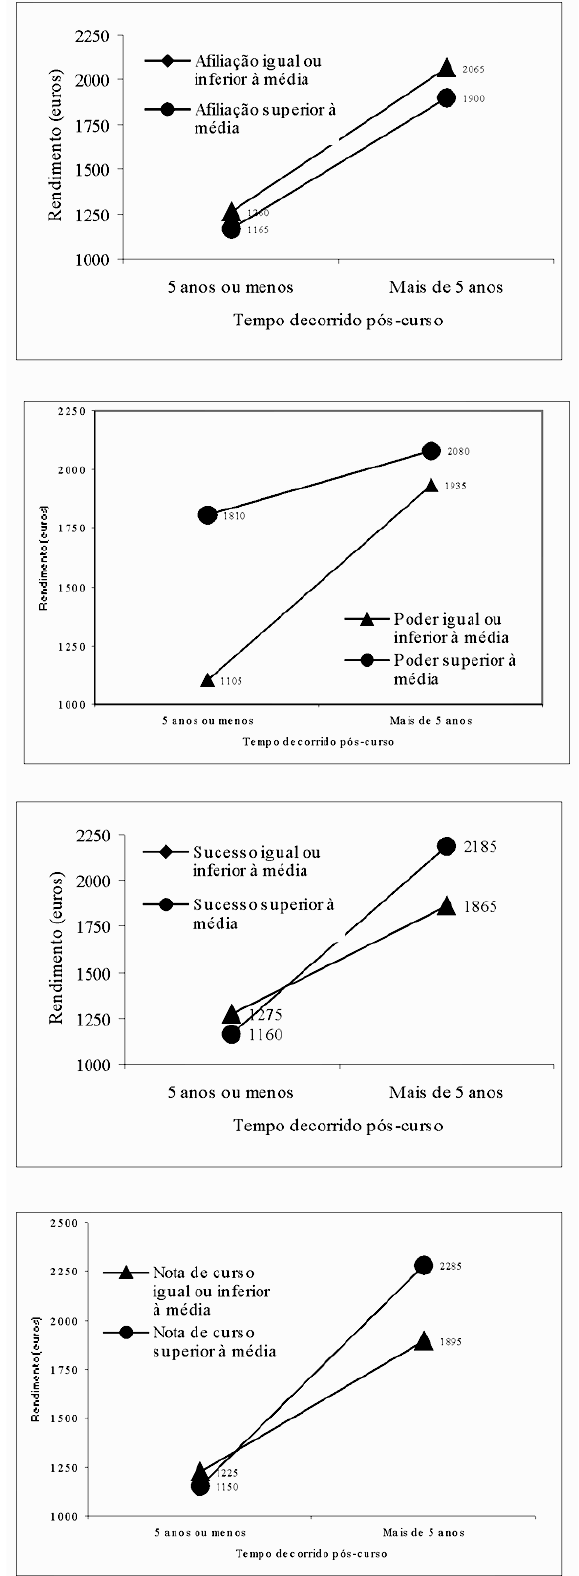
Figuras 1.1, 1.2 , 1.3, 1.4. Como os motivos, a mØdia final de curso e